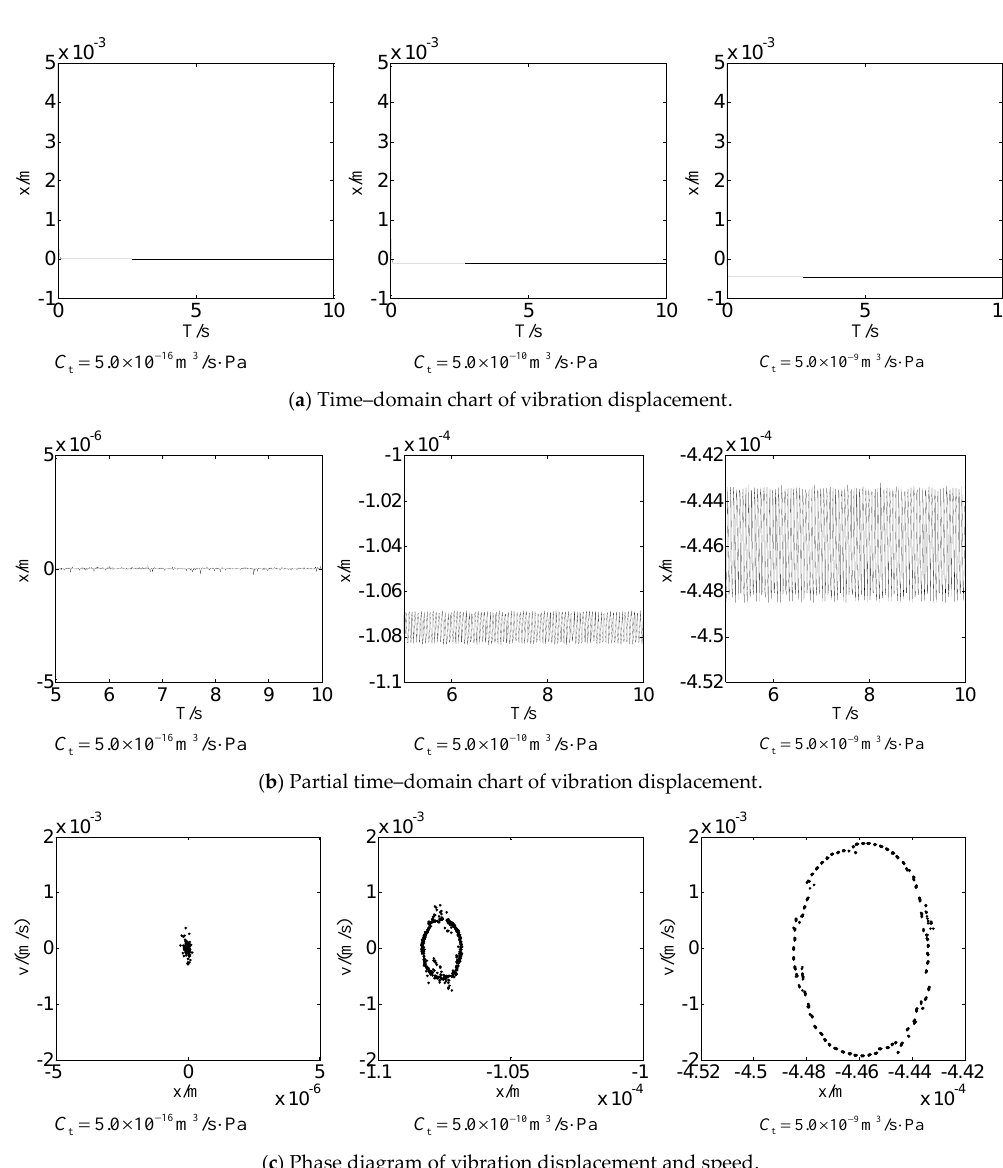
Figure 6. E ff ect of leakage coe ffi cient on hydraulic cylinder vibration Figure 6. Effect of leakage coefficient on hydraulic cylinder vibration response.